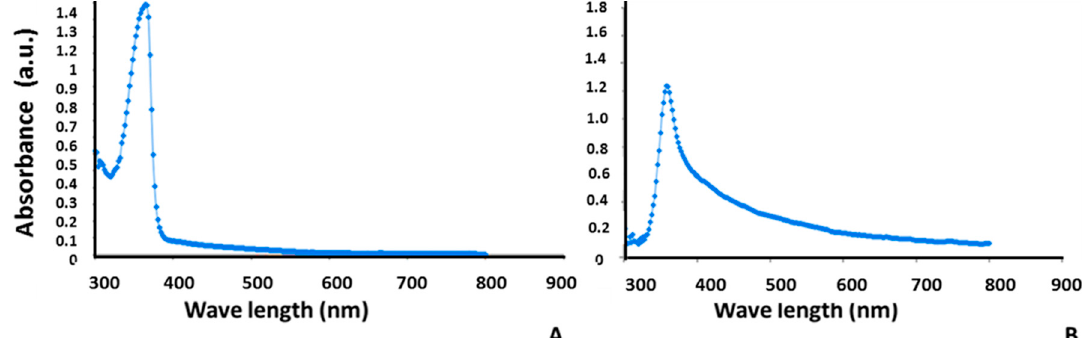
Figure 3. UV-visible absorption spectroscopy for bromocriptine ( A ) and alginate-bromocriptine nanocomposite ( B ).